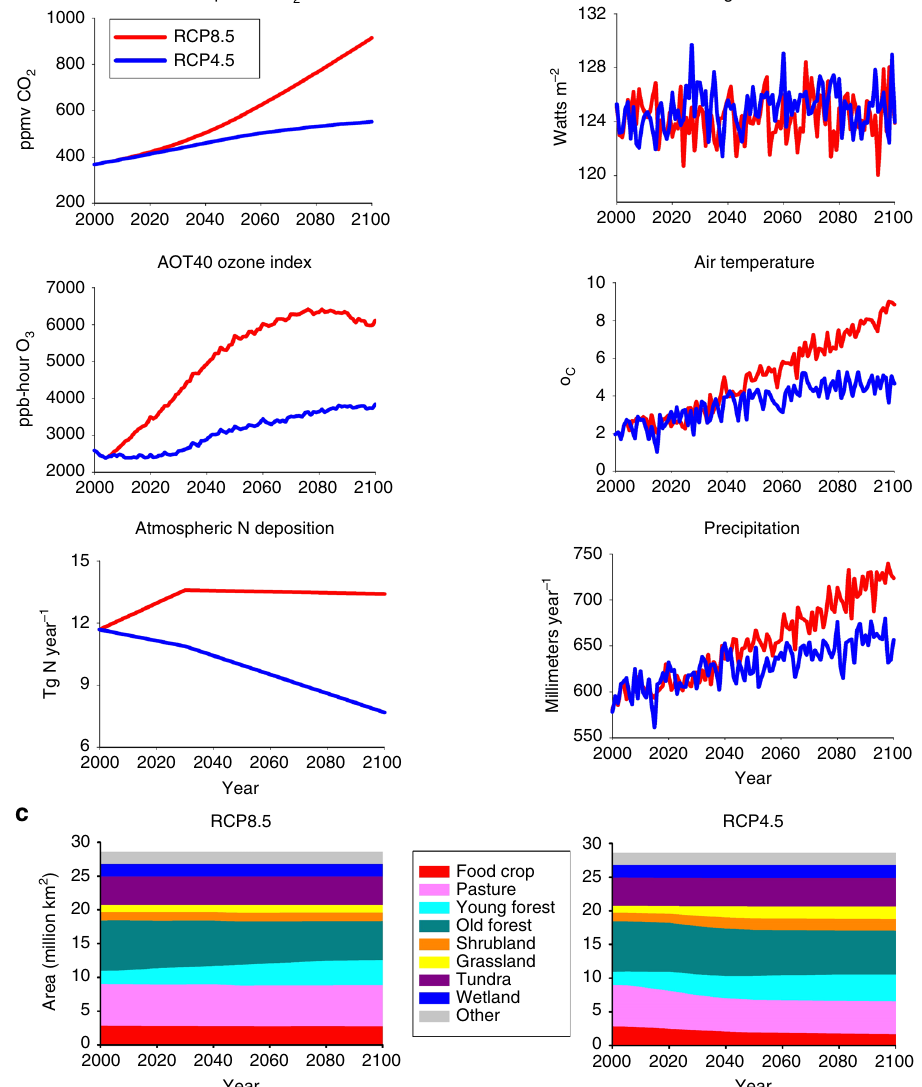
Fig. 2 Regional characteristics of projected global change by the RCP8.5 and RCP4.5 scenarios during the 21st century for Northern Eurasia. a Atmospheric chemistry as represented by mean annual atmospheric CO 2 concentrations, mean annual AOT40 ozone index, and annual atmospheric N deposition. b Climate as represented by mean annual incoming solar radiation, mean annual air temperature, and annual precipitation. c Land-cover